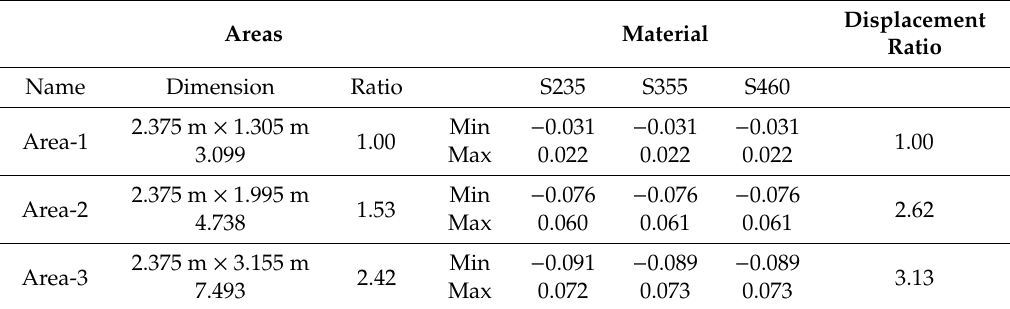
Table 10. Displacement of plate for areas in